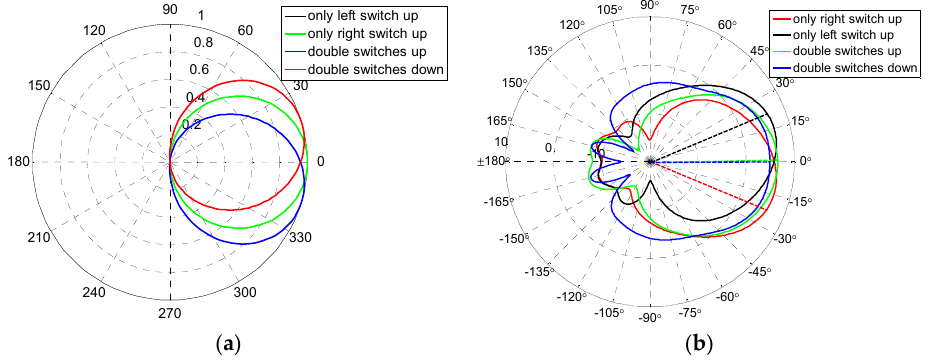
Figure 6. Radiation patterns of reconfigurable antenna. ( a ) Theoretical evaluation of patterns; ( b ) Simulation of patterns.